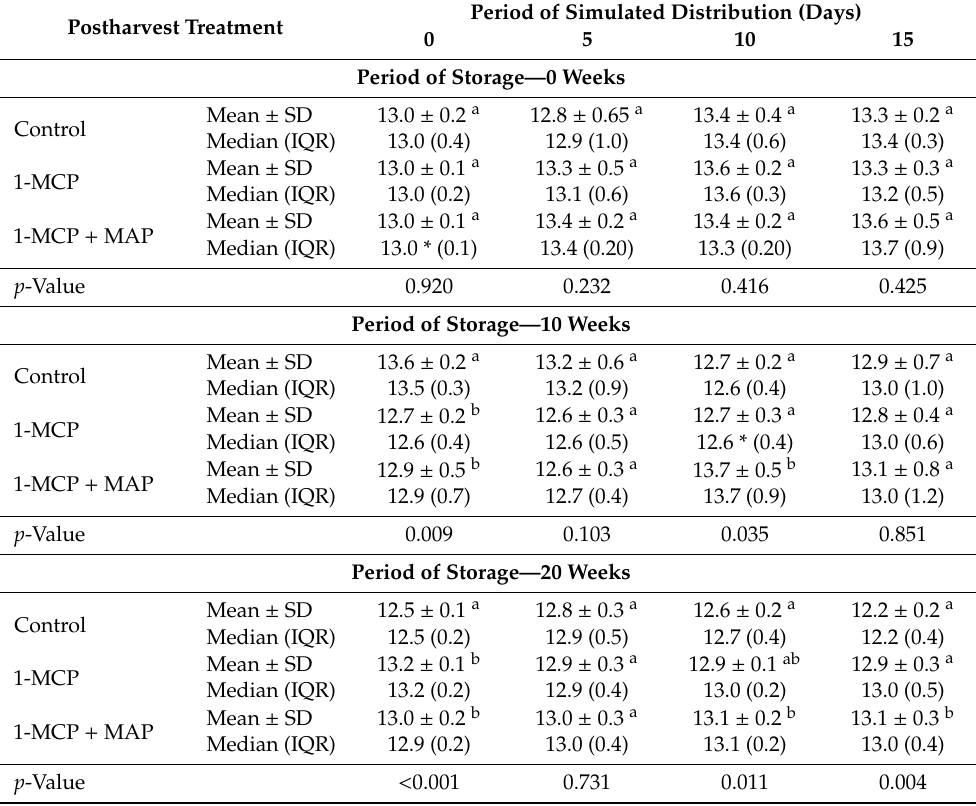
Table 3. The Total Soluble Solids (TSS) content [ ◦ Bx] values of ‘Idared’ apples after Ultra Low Oxygen (ULO) storage, simulated long-distance transport, and simulated distribution, stratified by postharvest treatment, period of storage and period of